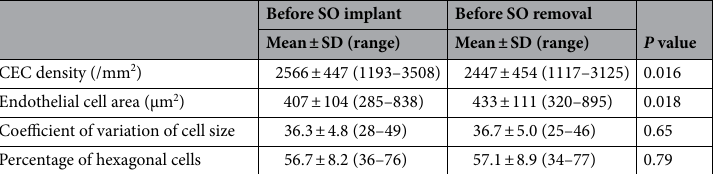
Table 3. Change of CEC between before SO implant and before SO removal. CEC, corneal endothelial cell; SO, silicone oil; SD, standard deviation.